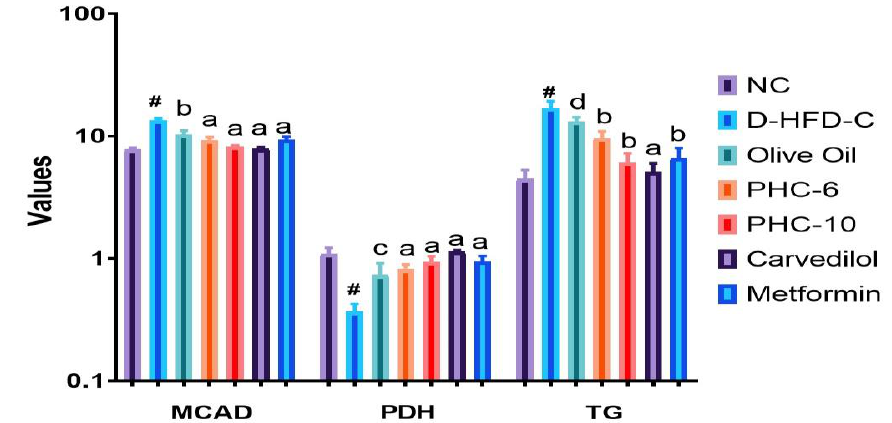
Figure 5. Cardiac marker activity. All values are expressed as mean ± SD ( n = 6) analyzed by one-way ANOVA followed by Tukey’s t -test. D-HFD-C was compared with NC ( # p < 0.0001), and the values were found to be highly significantly different. The different treatment groups were compared with D-HFD-C, with the values expressed in log 10 scale on the Y-axis, and the results for each parameter (MCAD, PDH and TG) were found to be different at the following significance levels: d p < 0.05; c p < 0.01; b p < 0.001; a p < 0.0001 from the respective disease control groups. NC is normal control; D-HFD-C is diabetic high-fat diet control group; PHC6 and PHC10 are polyherbal combination treated groups .